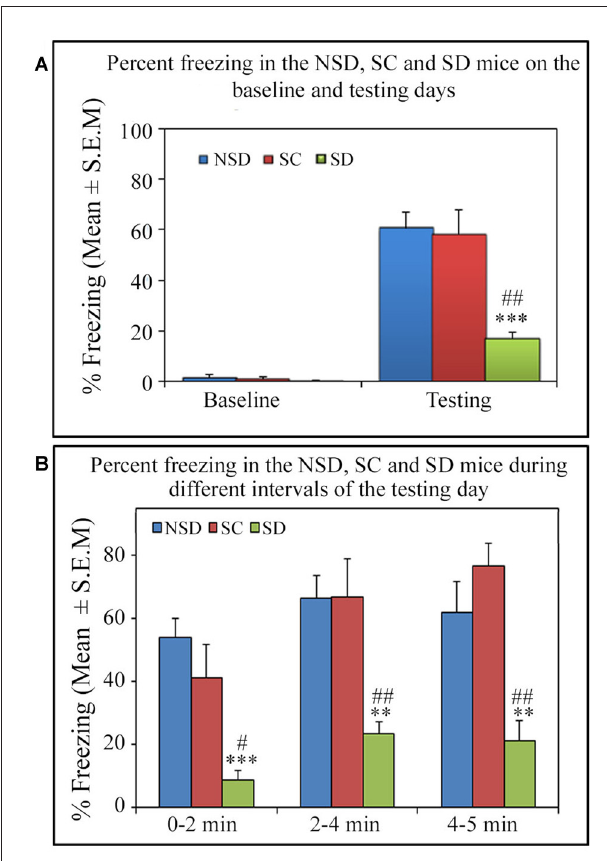
FIGURE 5 | The comparative changes in percent freezing response in the NSD, SC and SD animals. (A) The NSD, SC and SD animals showed a comparable freezing response on the baseline day. The percent freezing in the SD animals was significantly less ( p < 0.001, F ( 2,18 ) = 13.82) compared to the NSD (Tukey p < 0.001) and SC (Tukey p < 0.01) animals. (B) In the SD animals, the precent freezing was significantly less on the testing day during the 0–2 min (compared to NSD group: Tukey p < 0.001; compared to SC group: Tukey p < 0.05), 2–4 min (compared to NSD group: Tukey p < 0.01; compared to SC group: Tukey p < 0.01) and 4–5 min (compared to NSD group: Tukey p < 0.01; compared to SC group: Tukey p < 0.01) time periods (the corresponding times of pre-shock, shock and post-shock periods of the training day). ∗∗ p < 0.01 and ∗∗∗ p < 0.001 (compared to NSD group); # p < 0.05 and ## p < 0.01 (compared to SC group).